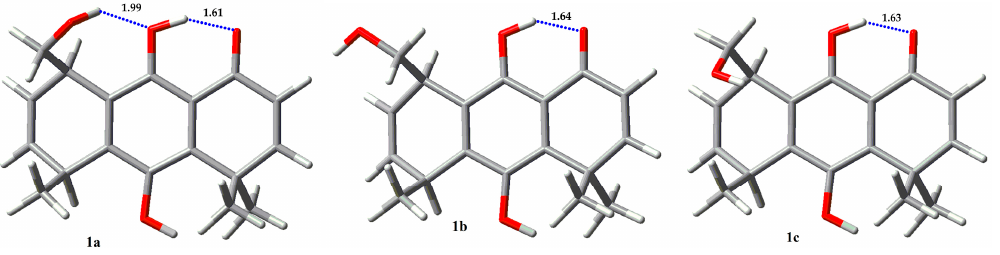
Figure 3. Rotamers generated by rotation of dihedral angle H8(5)-C8(5)-C1 ′ R1R2-OH (molecules 1 to 4 ) or H9(6)-C9(6)-C1 ′ R1R2-OH (molecules 5 and 6 ).